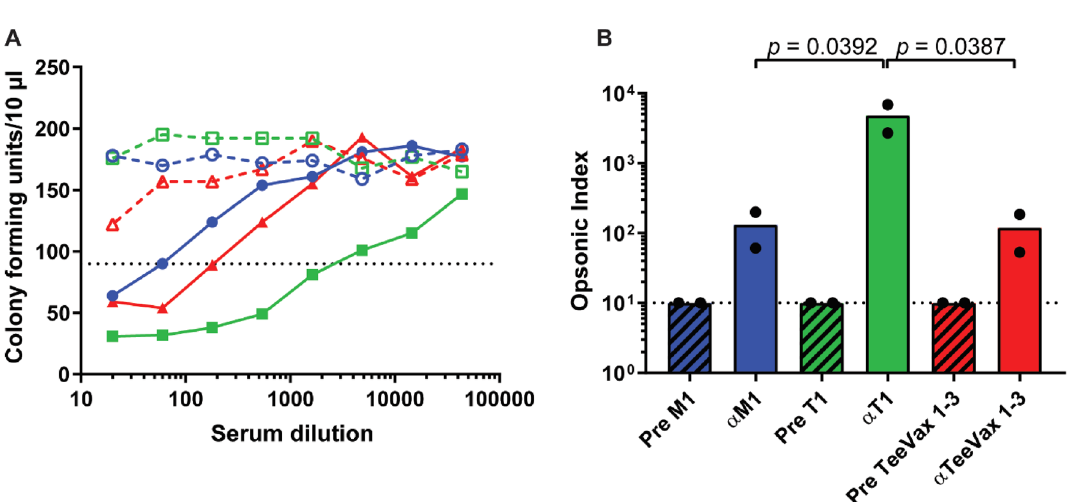
Figure 3. OPKA of rabbit antiserum. Sera from immunised rabbits were tested in an OPKA against GAS SF370 (M1T1 strain). ( A ) Representative line graph showing CFU recovered after incubation with serial dilutions of M1 (blue), T1 (green), and TeeVax1 (red) antiserum. Open symbols indicate pre-immune sera, solid symbols indicate immune sera. Serum dilution resulting in 50% killing is denoted by the point at which the curve crosses the dotted line which is used to calculate the opsonic index. ( B ) Opsonic index (n = 2) calculated from the serum dilution resulting in 50% killing. Each biological replicate is plotted (circles), with bar representing the mean. Hashed bars indicate pre-immune serum (Pre), solid bars indicate immune serum. Dashed line denotes the limit of